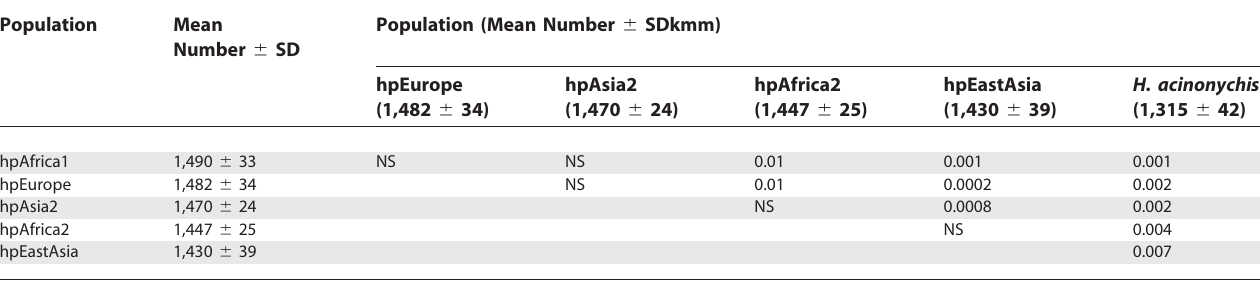
Table 2. Significance of Differences in Mean Numbers of CDSs between Different Populations